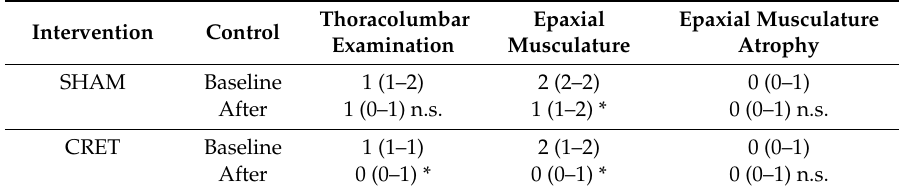
Table 3. Median and quartiles of back examination in 9 horses subjected to 4 capacitive resistive electric transfer (CRET) during 2 consecutive weeks compared with 9 horses subjected to a SHAM procedure (machine with the power o ff ).